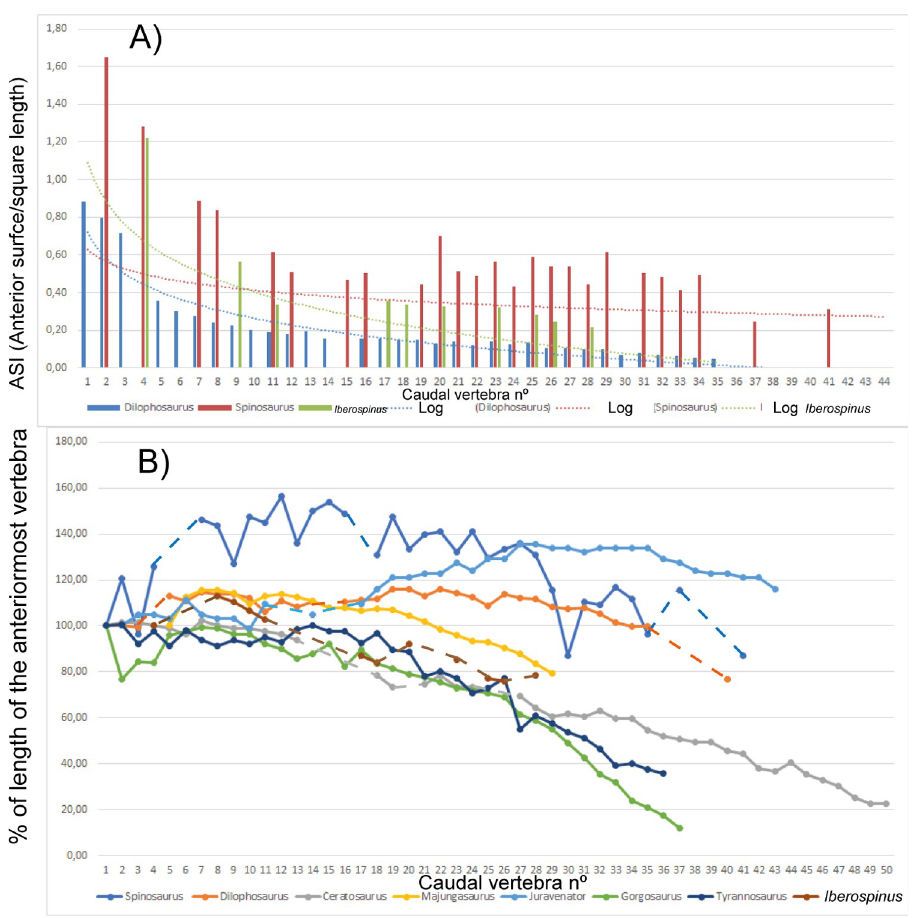
Fig 30. Metrics of the caudal vertebrae series of Iberospinus natarioi (ML1190) compared with other theropods. A , ASI/square length for each vertebra; B , percentageof the length for each caudal vertebra compared with that of the anterior-most preserved